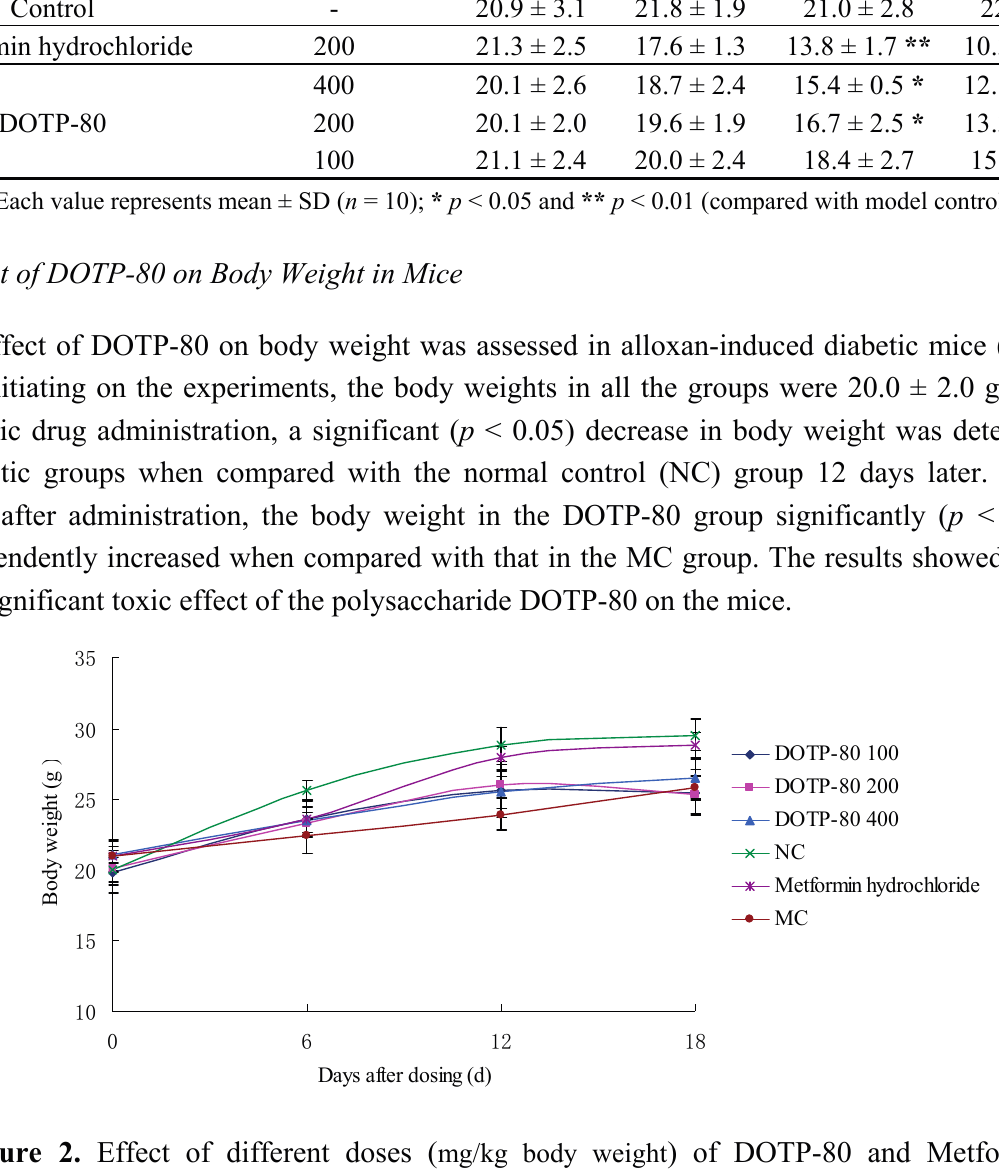
Table 2. Effect of DOTP-80 on plasma glucose level in alloxan-induced diabetic mice. Plasma Glucose Level (mmol/L) Dose Groups (mg/kg Body wt.) Day 0 Control -